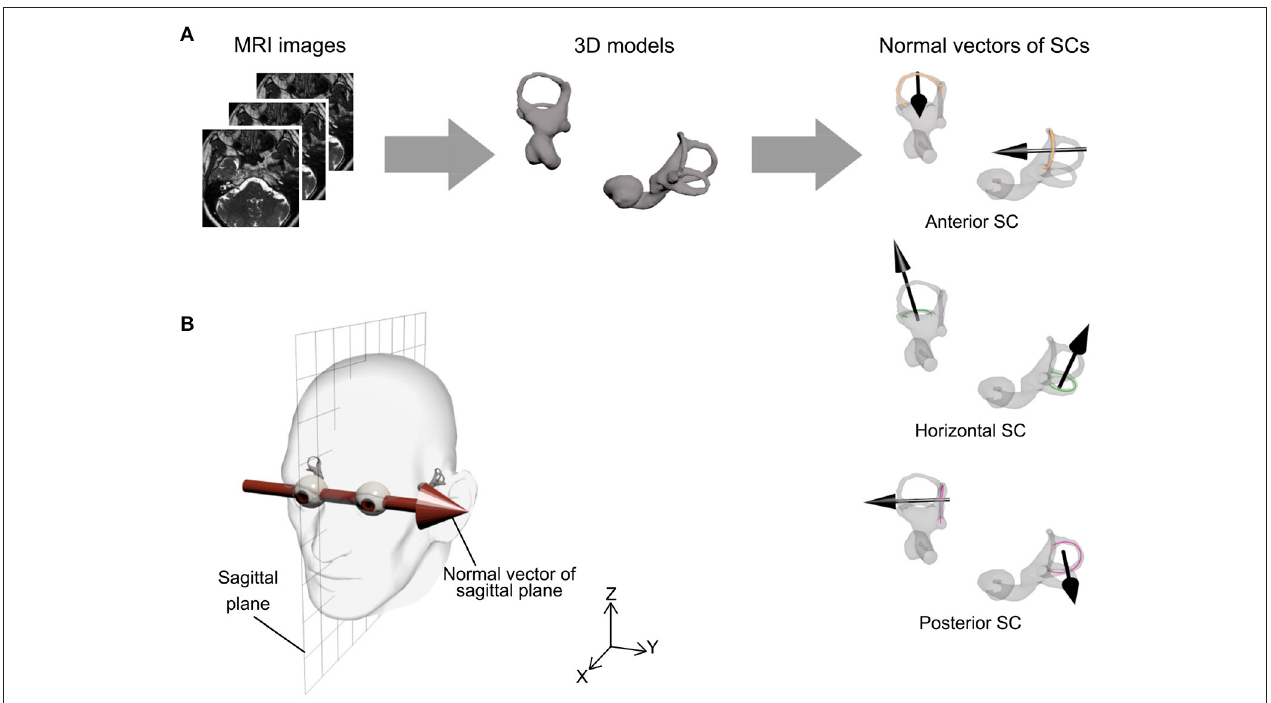
FIGURE 1 | Procedure for semicircular canal (SC) orientation and sagittal plane. (A) Bilateral vestibular organ information was extracted from magnetic resonance imaging (MRI) scans and reconstructed as a three-dimensional model. For each SC, a centerline of SC was estimated by three-dimensional image processing software and the normal vector of the SC was then determined by principal components analysis (black arrow). (B) The sagittal plane was defined by a connecting vector of the eyes’ centroids as normal vector (Y-axis) and the center of eyes’ centroids as position (XZ